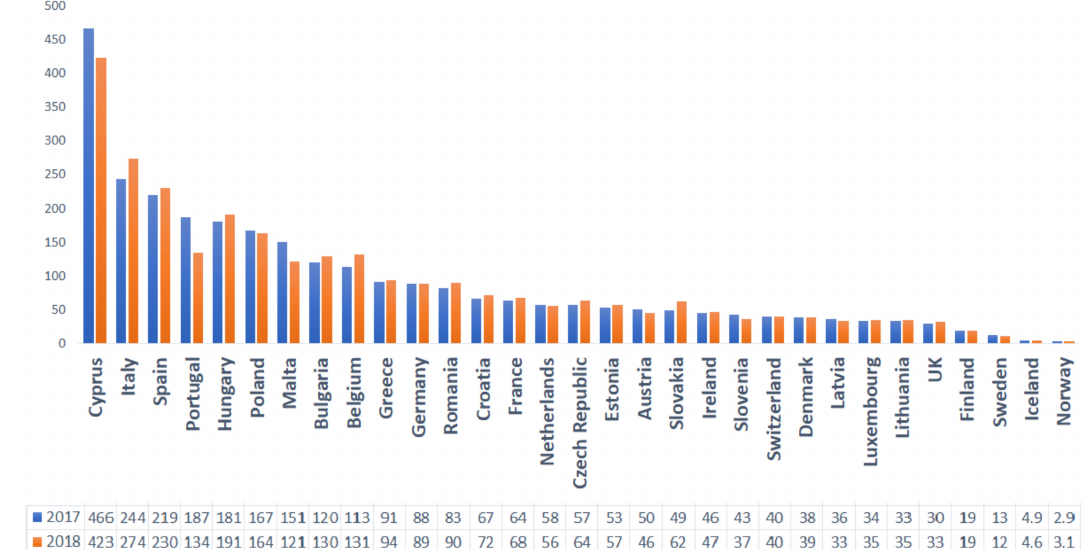
Figure 4. Overall sales for food-producing animals (including horses), in mg per population correction unit (mg/PCU), of the various veterinary antimicrobial classes, by country, for 2017 and